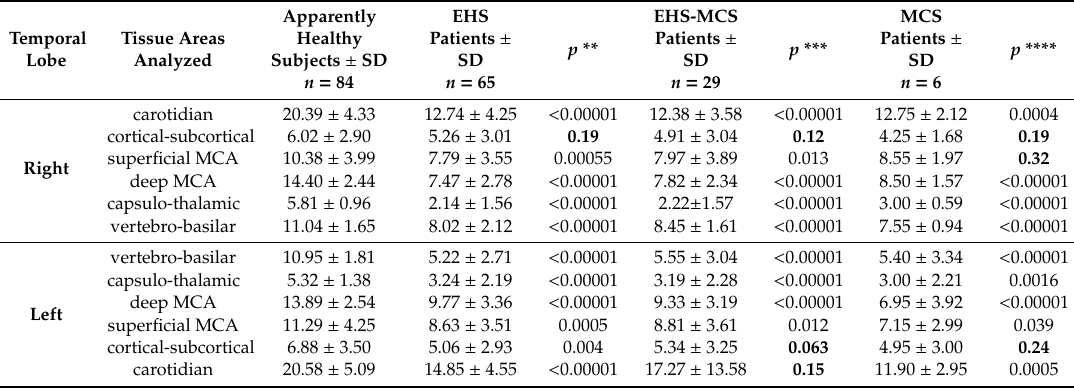
values indicates no-statistical